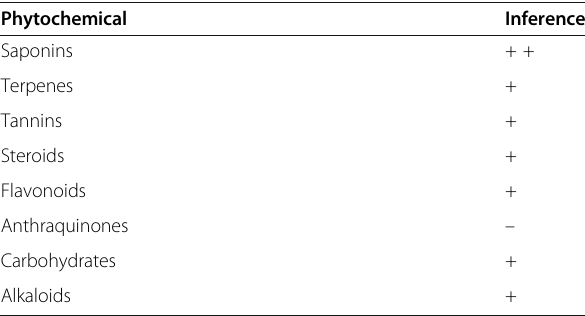
Table 1 Phytochemical constituents of aqueous methanolic extract of Andira inermis stem bark Phytochemical